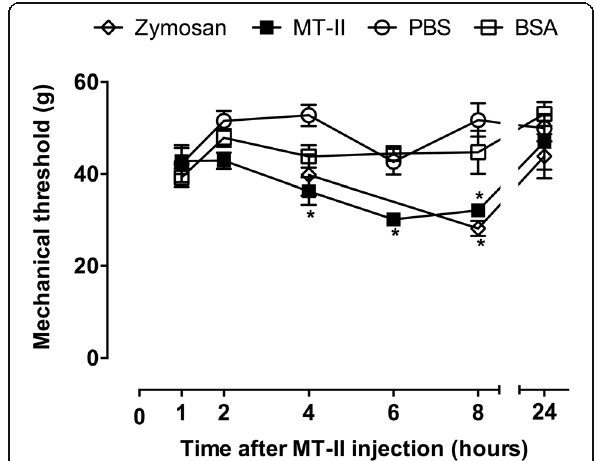
Fig. 1 MT-II-induced articular hyperalgesia. MT-II (10 μ g/joint) or PBS (vehicle) was injected in tibio-tarsal articulation (25 μ L). Pain threshold was determined by a dorsal flexion of the tibio-tarsal joint using a modified electronic pressure-meter test before (time 0 – basal) and 1, 2, 4, 6, 8 e 24 h after MT-II injection, and was represented as force (in g ). Zymosan (30 μ g) and BSA (20 μ g) were used as controls. Each point represents the mean ± SEM of six animals. * p <0.05 indicate statistically significant differences when compared